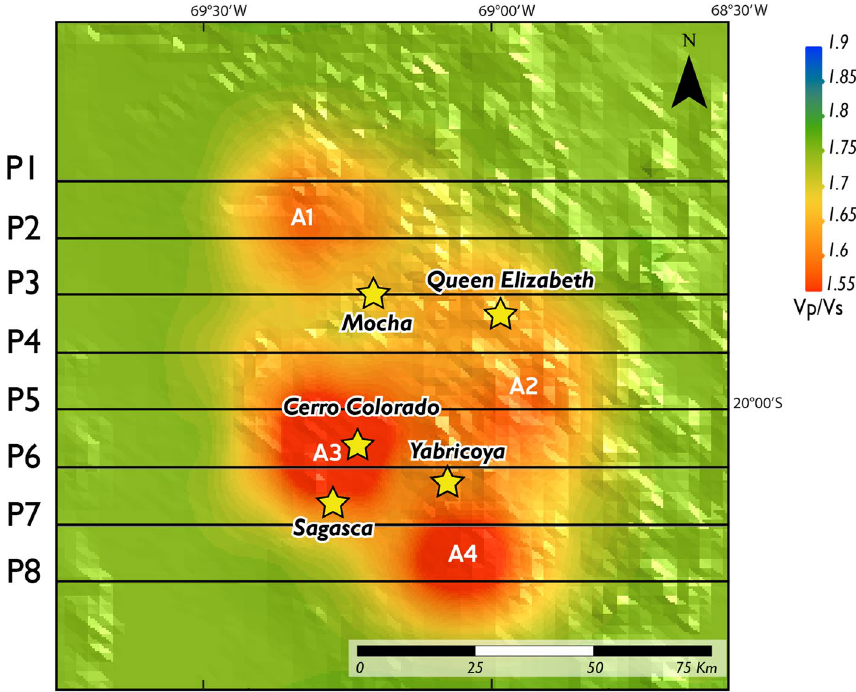
Figure 4. Plan-view map for Vp/Vs ratios of the study area (Figs. 2 and 3). The black lines denote the extracted profiles for the vertical Vp/Vs vertical sections shown in Fig. 5. The yellow stars correspond to historical porphyry copper deposits and prospects included in the study area. A1 to A4 correspond to the low Vp/Vs anomalies described in the text. Data georeferencing was carried out with ArcGIS Pro10.1 (www. esri. com). The software used to generate this figure was Leapfrog 2022.1 (www. seequ ent. com) and the final editing was done with Adobe Illustrator 2022 (www. adobe.